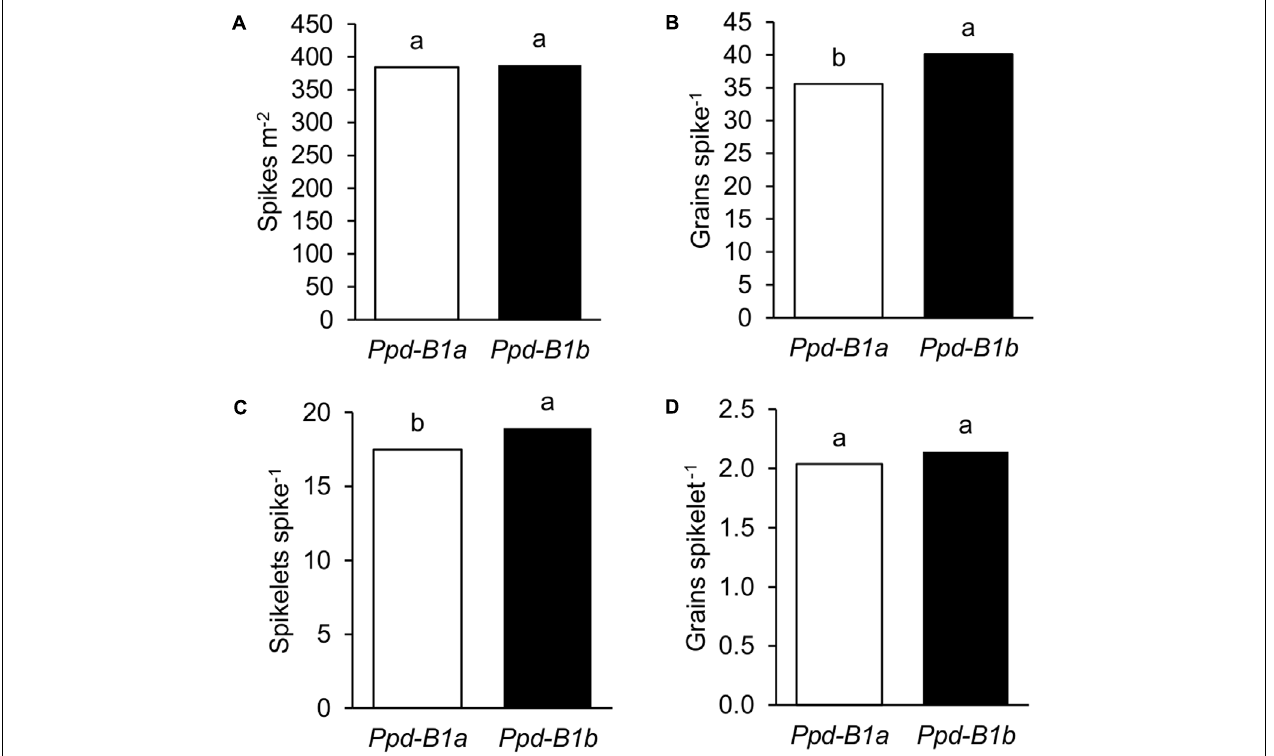
FIGURE 3 | Detailed yield components of 23 durum wheat genotypes grown in three sites of contrasting latitude during 2010, 2011, and 2012: (A) spikes m − 2 , (B) grains spike − 1 , (C) spikelets spike − 1 , and (D) grains spikelet − 1 . Each bar represents mean values of genotypes carrying Ppd-B1a or Ppd-B1b . Different letters indicate differences according to LSD test at P <